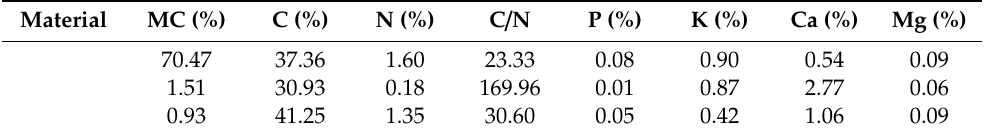
Table 2. Biodegradable municipal waste (BMW) used in